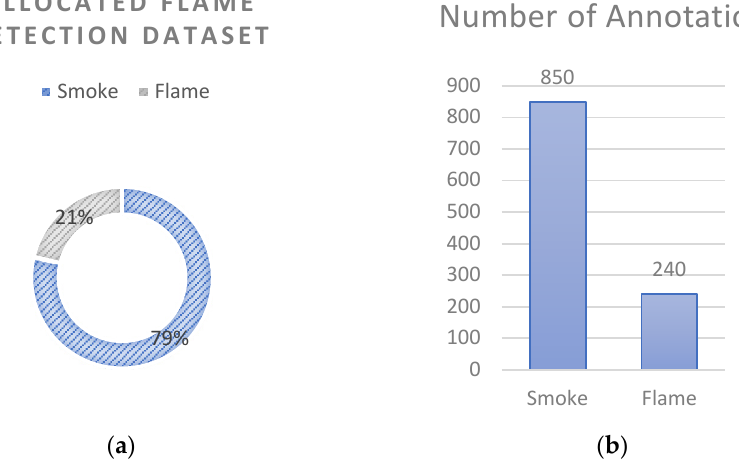
Figure 2. Dataset associated with the detection task: ( a ) number of samples in the dataset from the binary label (fire or smoke); ( b ) number of annotations in the images detected by the algorithm.